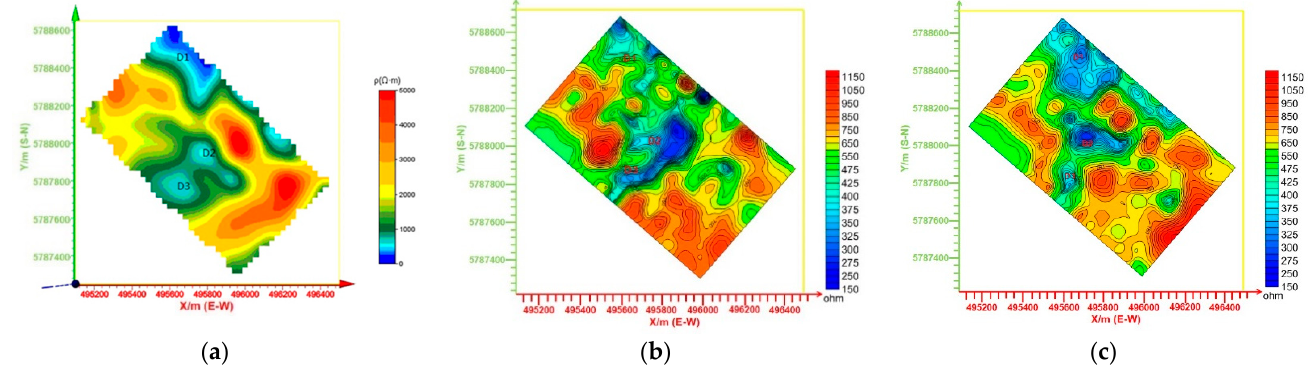
Figure 13. The detection results. ( a ) Investigation result of survey area provided by Heilongjiang Institute of Geophysical and Geochemical Exploration; ( b ) inversion result of original data; ( c ) inversion result after SSA de-noising.